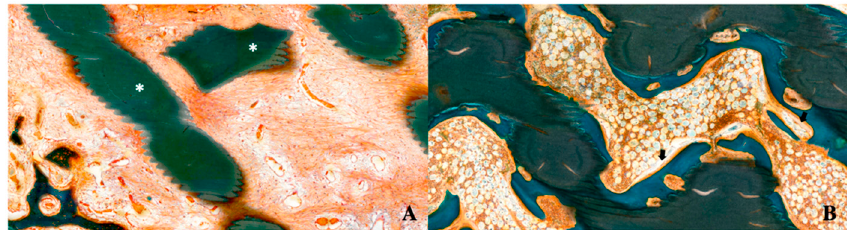
Figure 4. Histomorphometric evaluation at 4 and 8 weeks in the 3D printed substitute (3DS) group. ( A ) After 4 weeks. ( B ) After 8 weeks (white asterisk: grafted bone; black arrow: osteoblast).